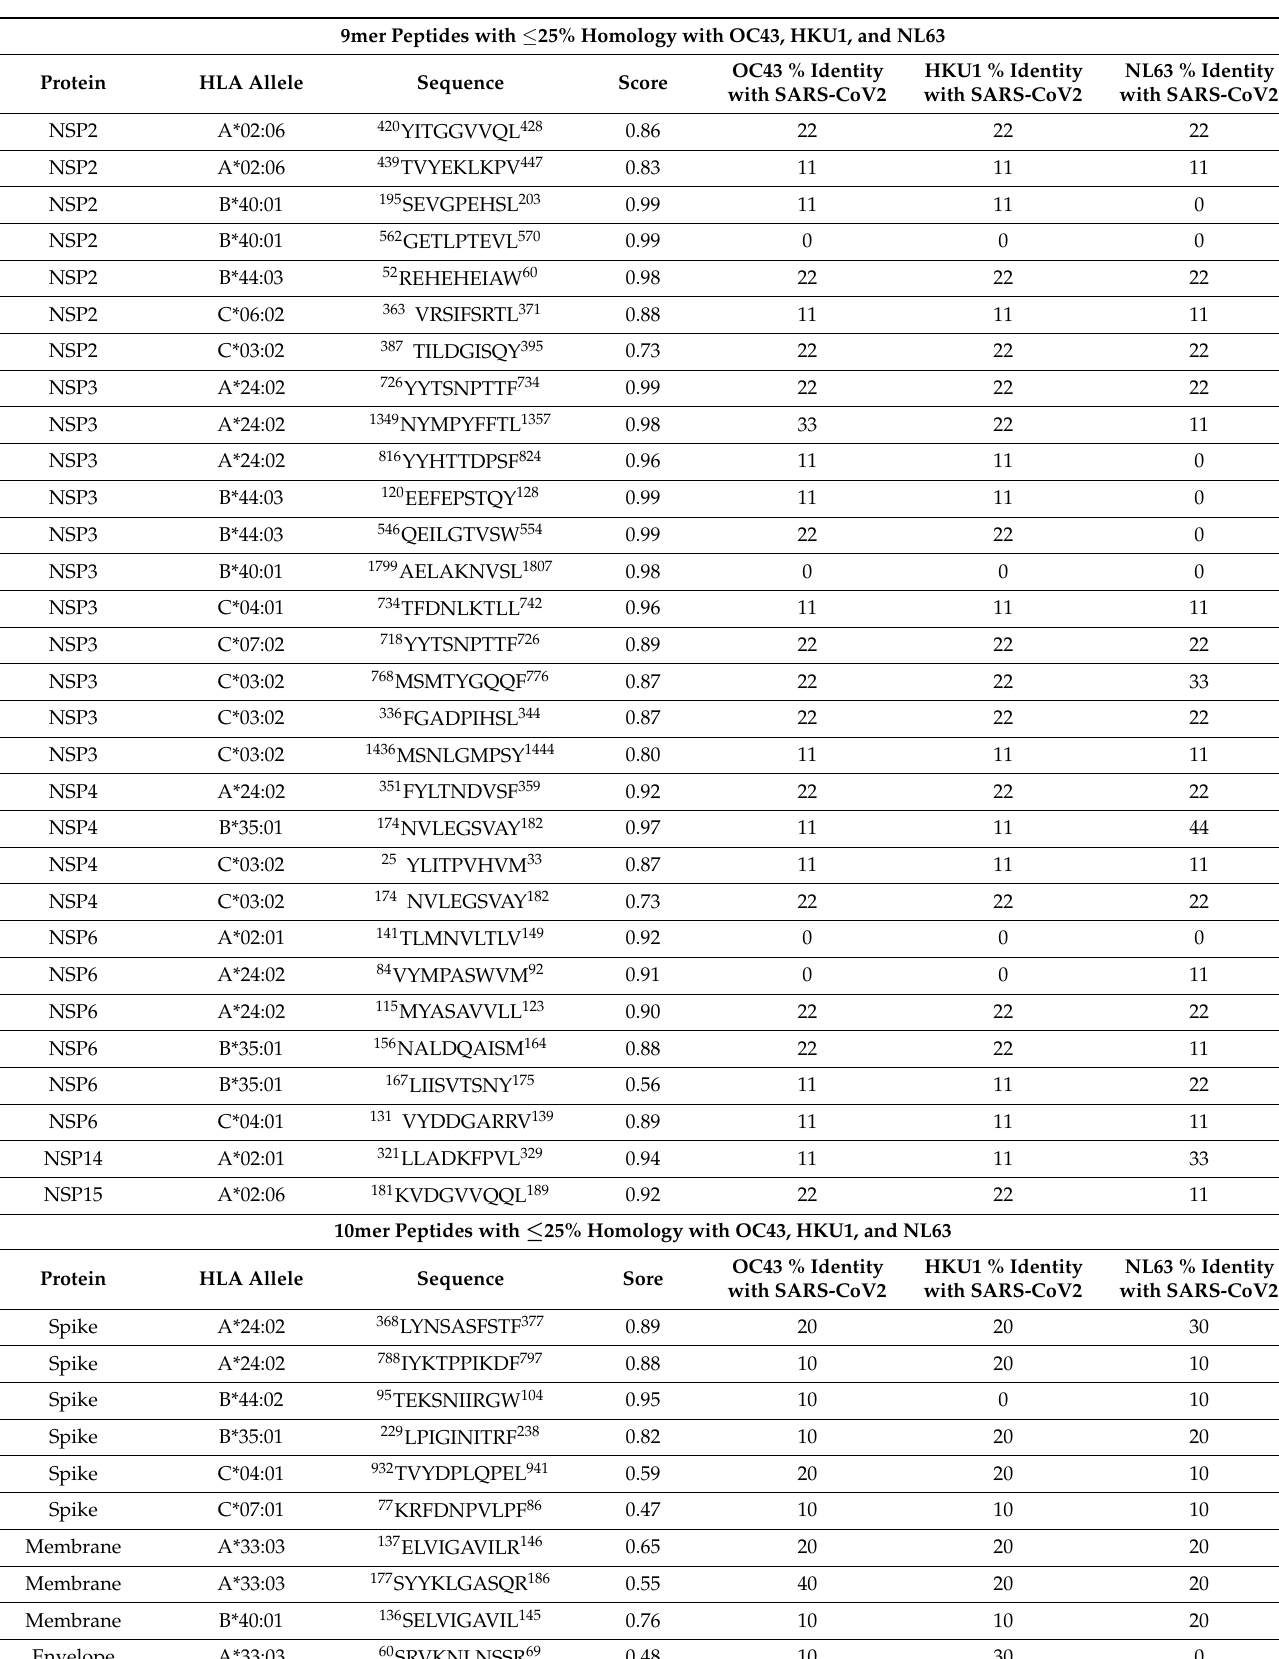
Table 5. Cont. 9mer Peptides with ≤ 25% Homology with OC43, HKU1, and